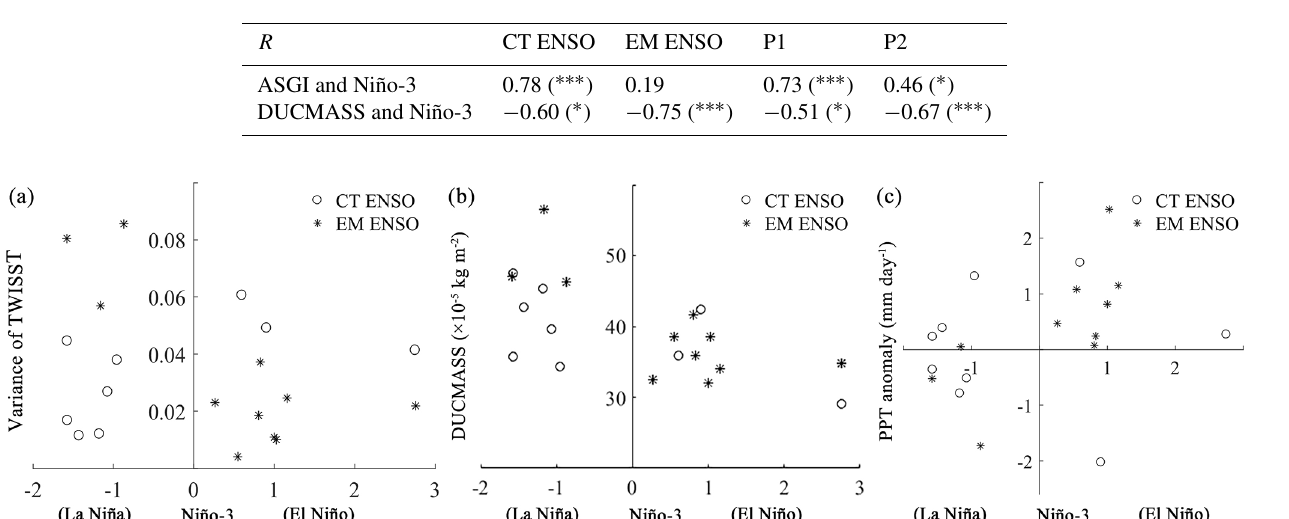
Table 3. Correlation between ASGI and Niño-3 as well as DUCMASS in two different phases ( ∗ and ∗∗∗ indicate the correlations that are significant at the 0.1 and 0.01 levels, respectively).